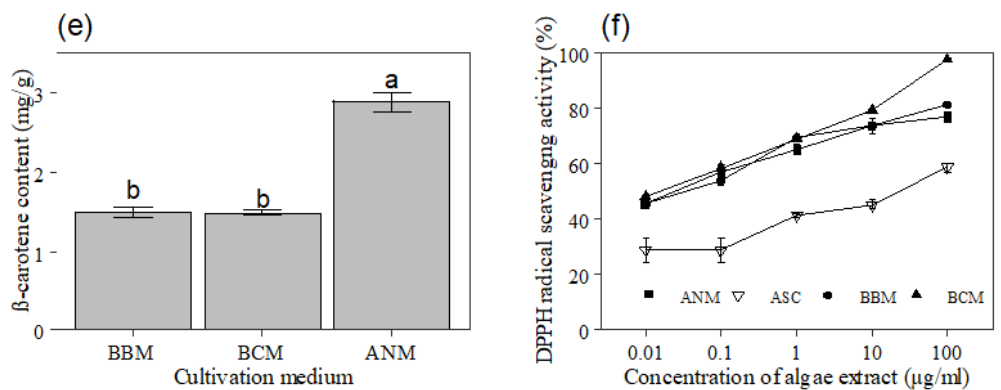
Figure 1. ( a ) Extraction yield; ( b ) Phenolic content; ( c ) Flavanoid content; ( d ) lycopene content; ( e ) β -carotene content and ( f ) DPPH radical scavenging activity of C. vulgaris grown in di ff erent media. (Means sharing the same letter are not significantly di ff